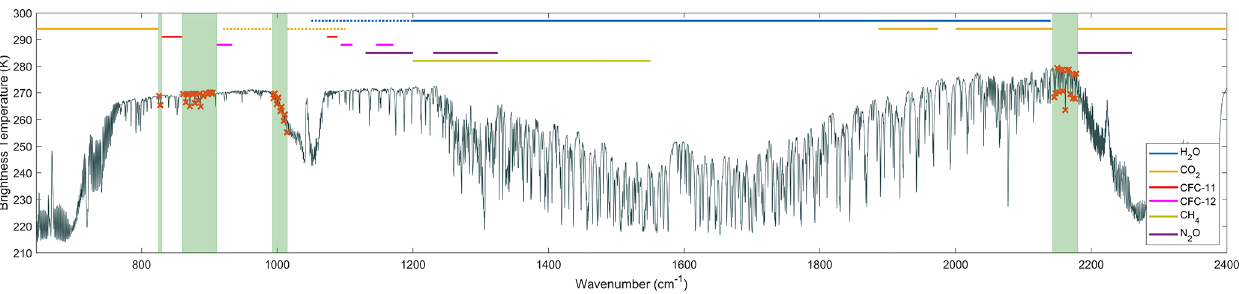
Figure 1. Mean IASI spectrum in brightness temperature with the 45 channels selected for the training displayed (red crosses). The shaded green area corresponds to the regions considered for the channel selection. The coloured lines on the top represent the regions of sensitivity to H 2 O, CO 2 , CH 4 , N 2 O, CFC-11 and CFC-12 excluded. Table 1. List of IASI wavenumbers selected for the training of the cloud detection neural